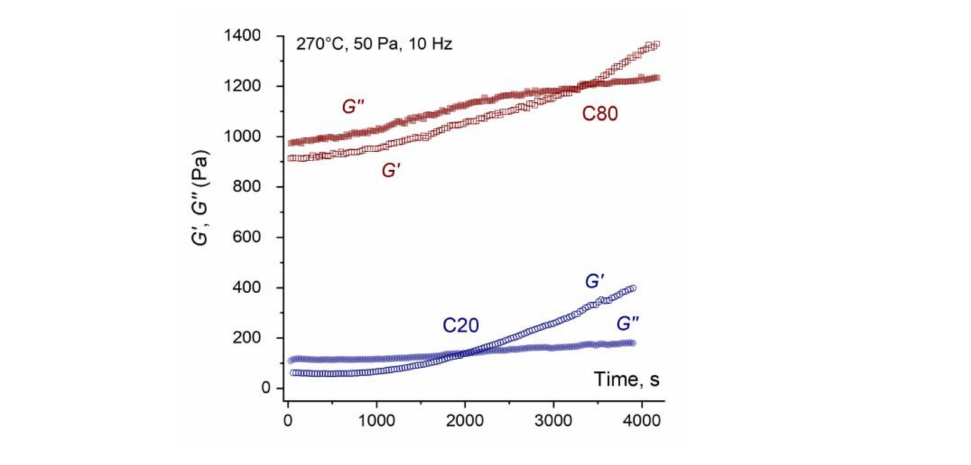
Figure 6. Evolution of the complex modulus components in time at strain of 50 Pa and frequency of 10 Hz for melts C20 and C80 at 270 ◦